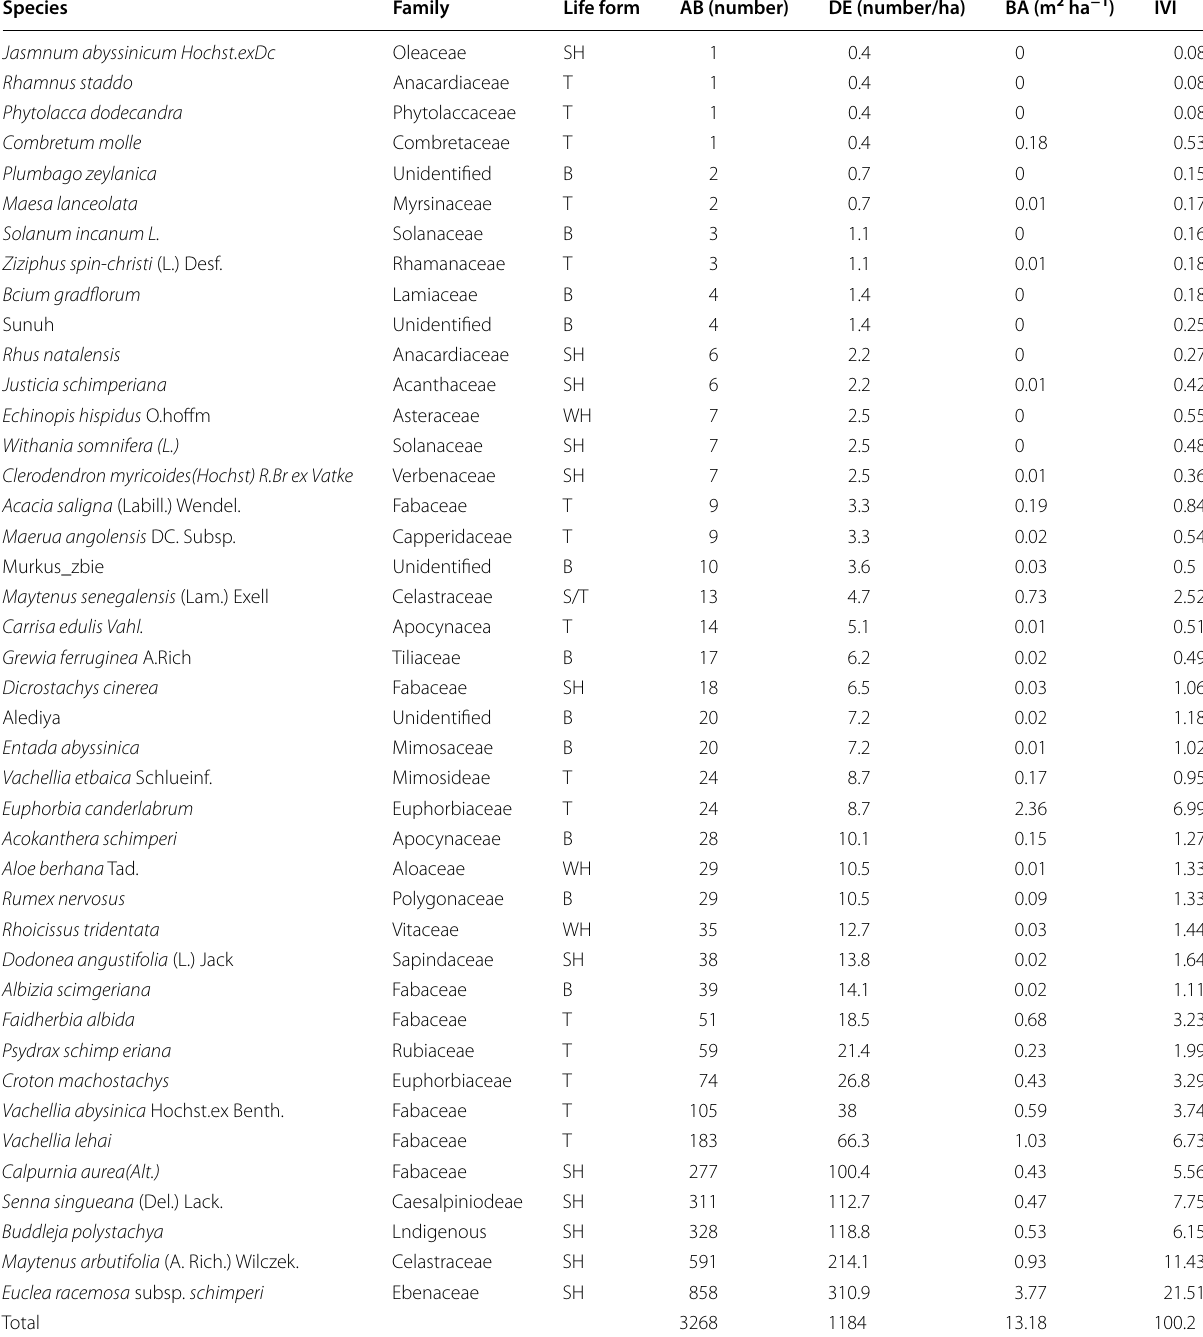
Table 3 Abundance (AB), density (DE), basal area (BA) and Importance Value Index (IVI) of woody plants in non-quarry